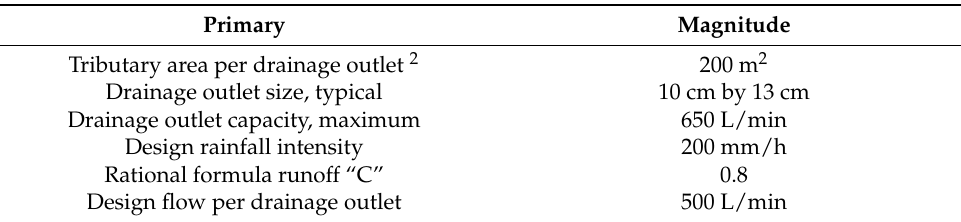
Table 2. Urban surface runoff criteria 1 for wall drainage outlets. (Reproduced from Machu